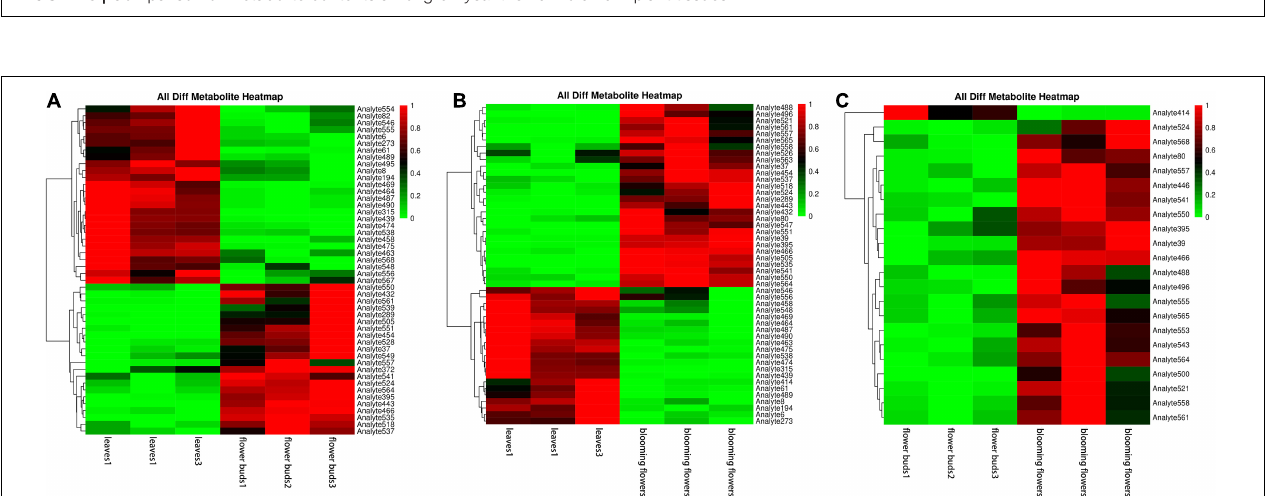
FIGURE 9 | Clustering heat maps of differentially abundant metabolites among Chrysanthemum dichrum plant tissues. The abscissa is the sample of each period, and the ordinate on the right is the name of the metabolite. The redder part of the heat map indicates the higher the metabolite content. (A) Is the differential metabolite clustering heat map of leaves and flower buds, and (B) is the differential metabolite clustering heat map of leaves and blooming flowers comparison group. (C) Is the heat map of different metabolites clustering between flower buds and blooming flowers comparison group.